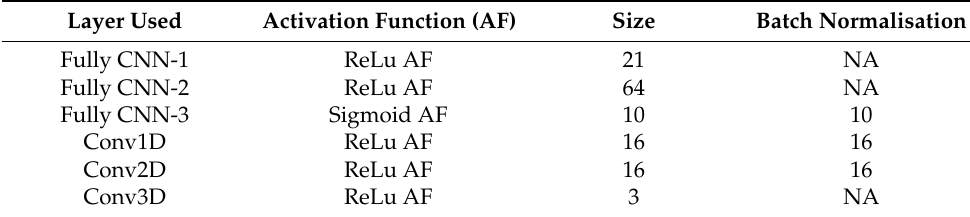
Table 2. Parameters of CNN Model in Proposed Hybrid